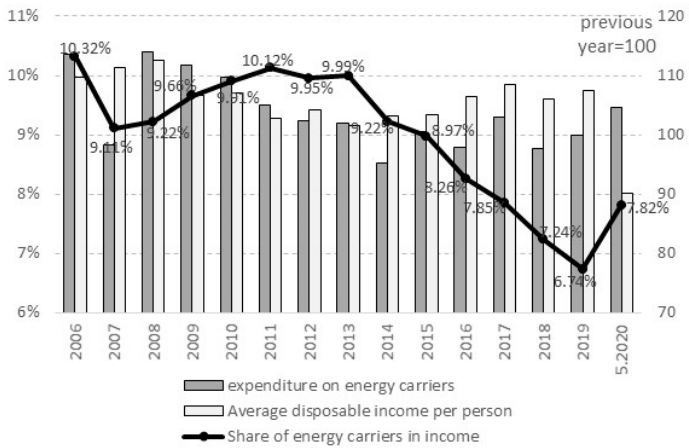
Figure 2. Ratio of expenditure on energy carriers to households’ average disposable income per capita (in %), dynamics of expenditure on energy carriers, and average disposable income per capita in Poland (previous years = 100). Source: own calculations based on [58–60].